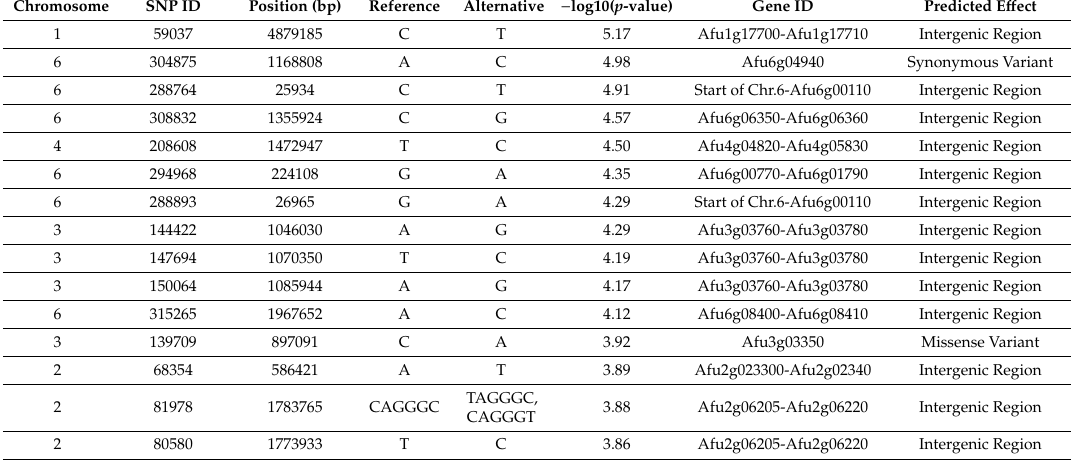
Table 6. Top 15 significant SNPs associated with AMB resistance based on a genome-wide association study (GWAS).